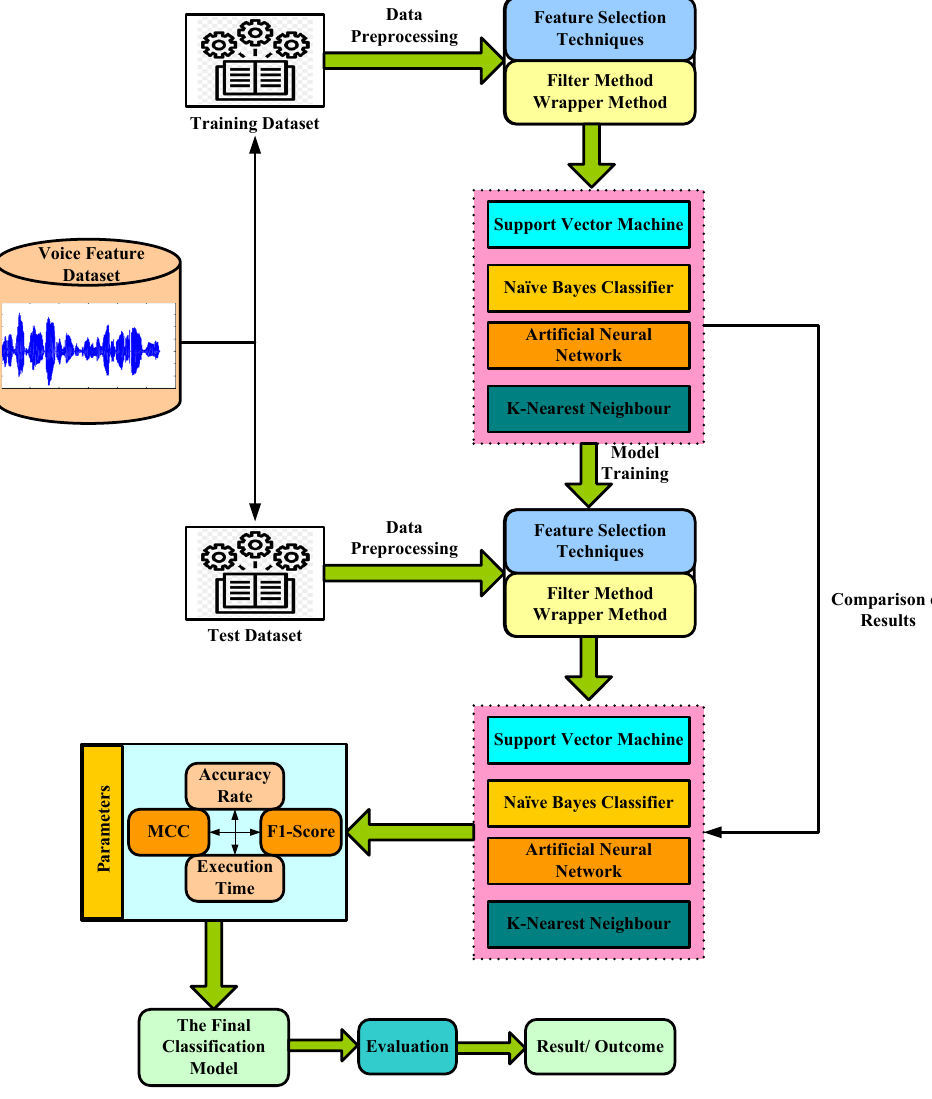
Figure 1. Diagram of the flowchart of the proposed work.